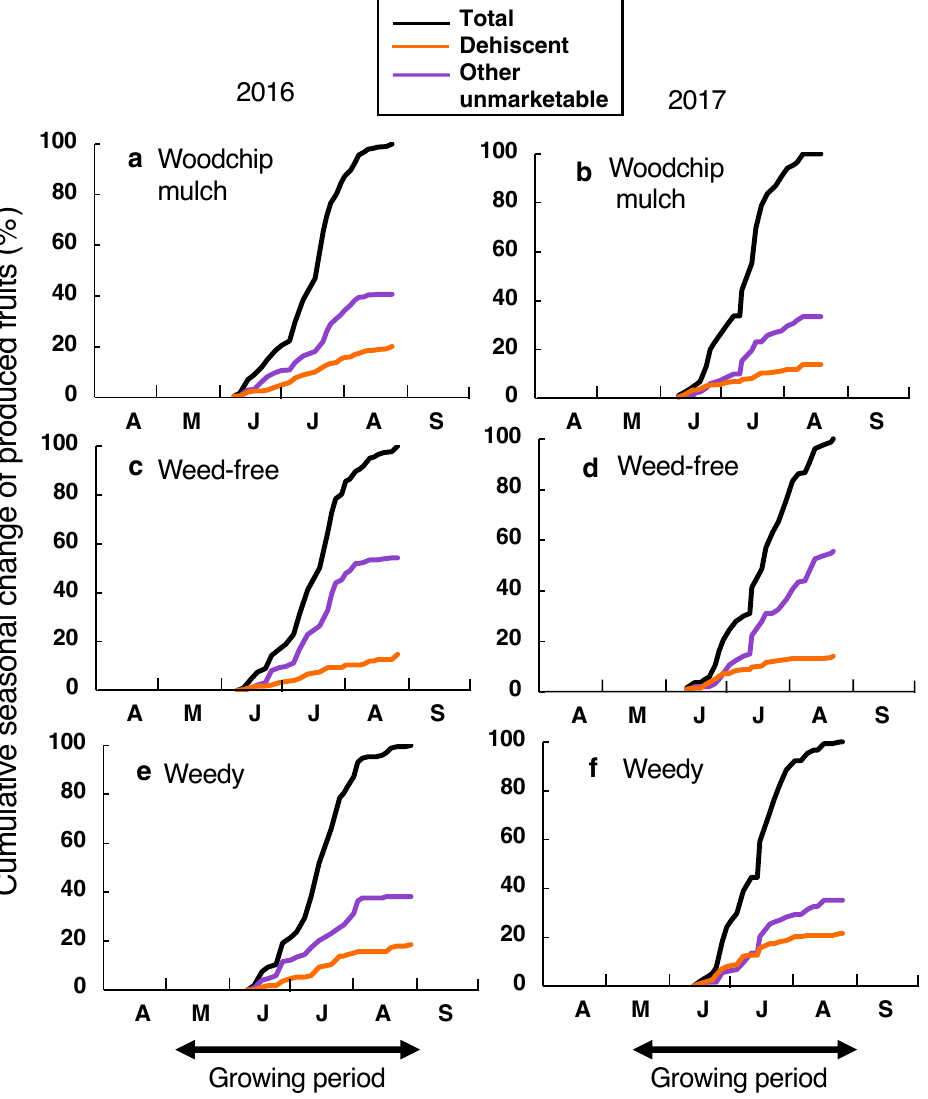
Figure 4. Cumulative seasonal changes in fruit production. The cumulative number of total fruits (black), the number of dehiscent fruits (orange) and the number of other unmarketable fruits (purple) during the fruit harvesting periods in ( a , b ) the woodchip mulch, ( c , d ) the weed free and ( e , f ) the weedy treatments ( a , c , e ) in 2016 and ( b , d , f ) in 2017. Fruit harvesting started on 11 June 2016 and on 12 June 2017. The growing period in each year is shown by a double-headed arrow. See Fig. 2 for harvested fruit